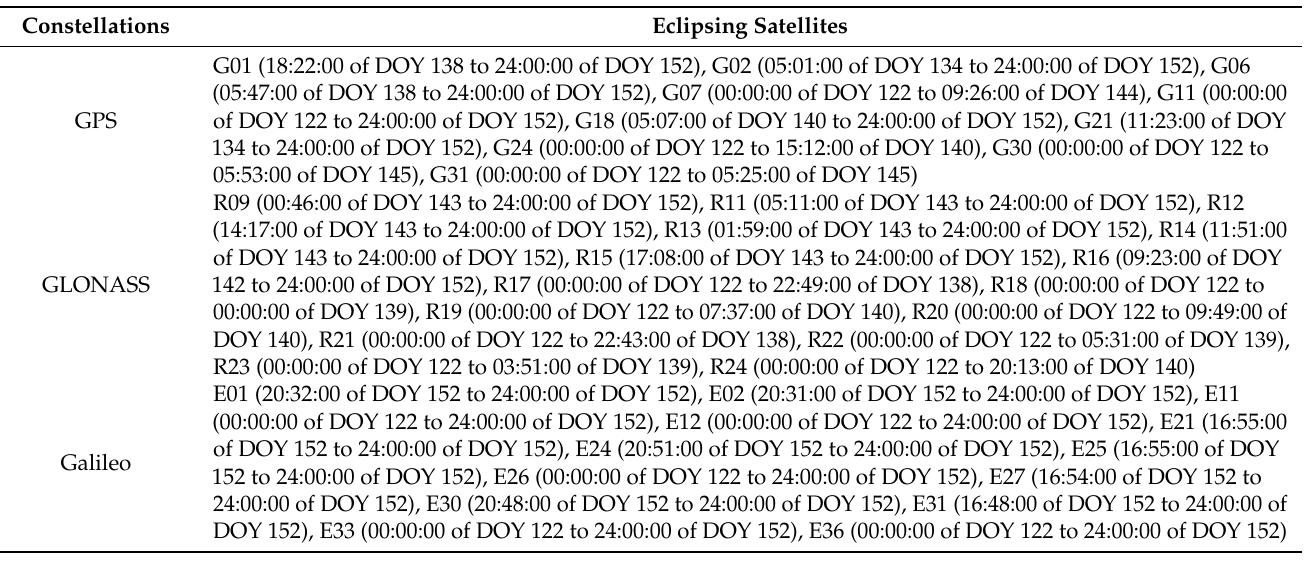
Table A1. Eclipsing satellites during the analysis period (DOY 122 to 152 in 2020). Constellations Eclipsing Satellites